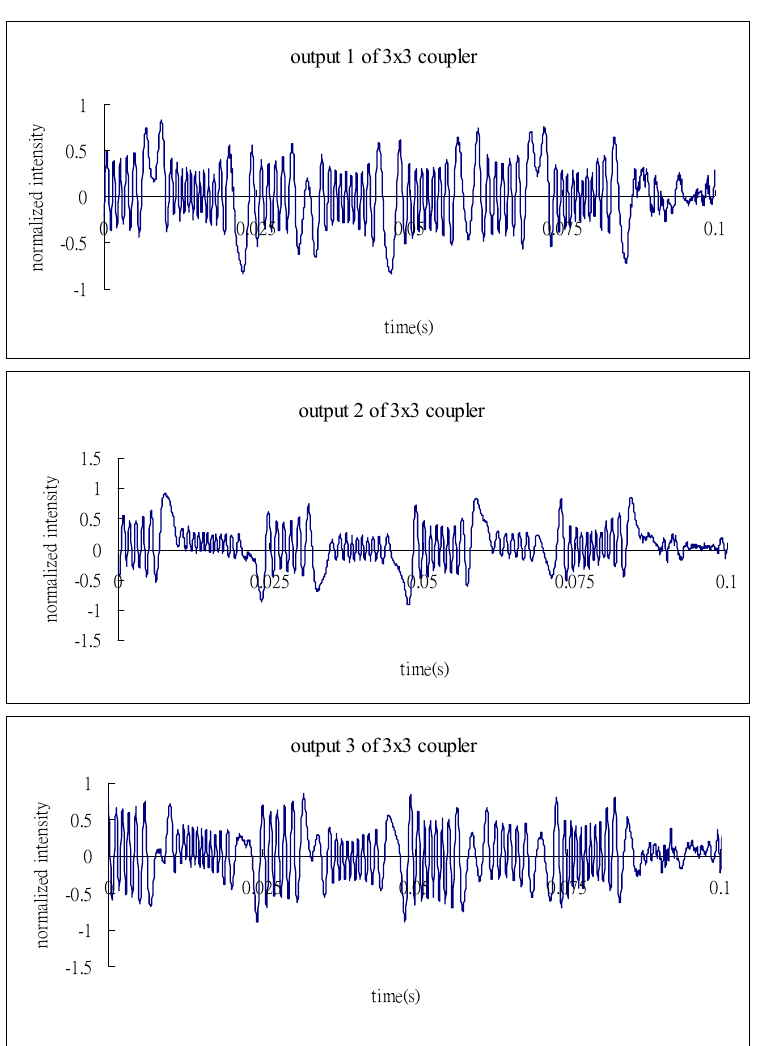
Figure 10. Three outputs of the 3 × 3 coupler with dual excitation frequencies of 7 Hz and 40 Hz.